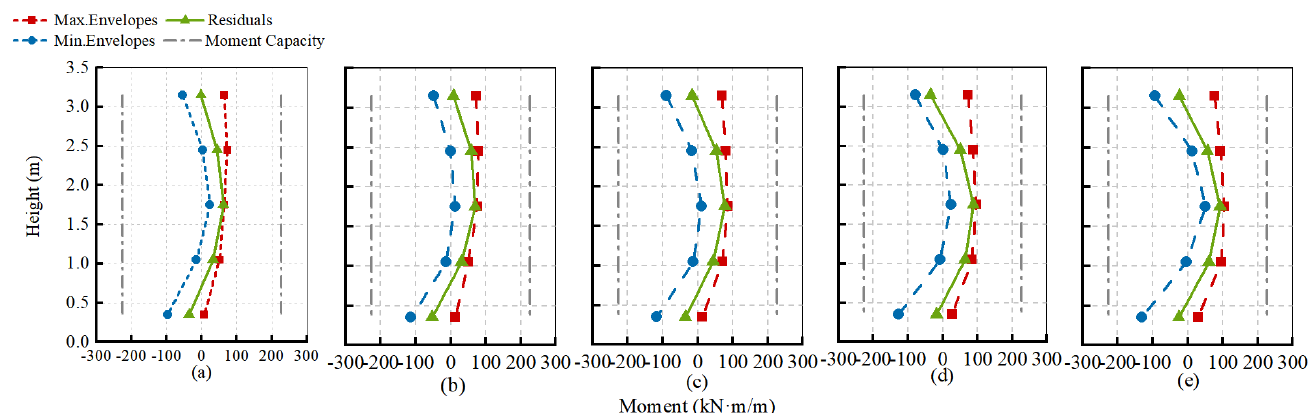
Figure 12. Maximum and minimum envelopes, residual values, and design capacity value of the left wall moment distribution during the earthquake, the data in ( a ), ( b ), ( c ), ( d ), and ( e ) are from numerical models for 2 m, 2.5 m, 3 m, 3.5 m and 4 m burial depths, respectively.